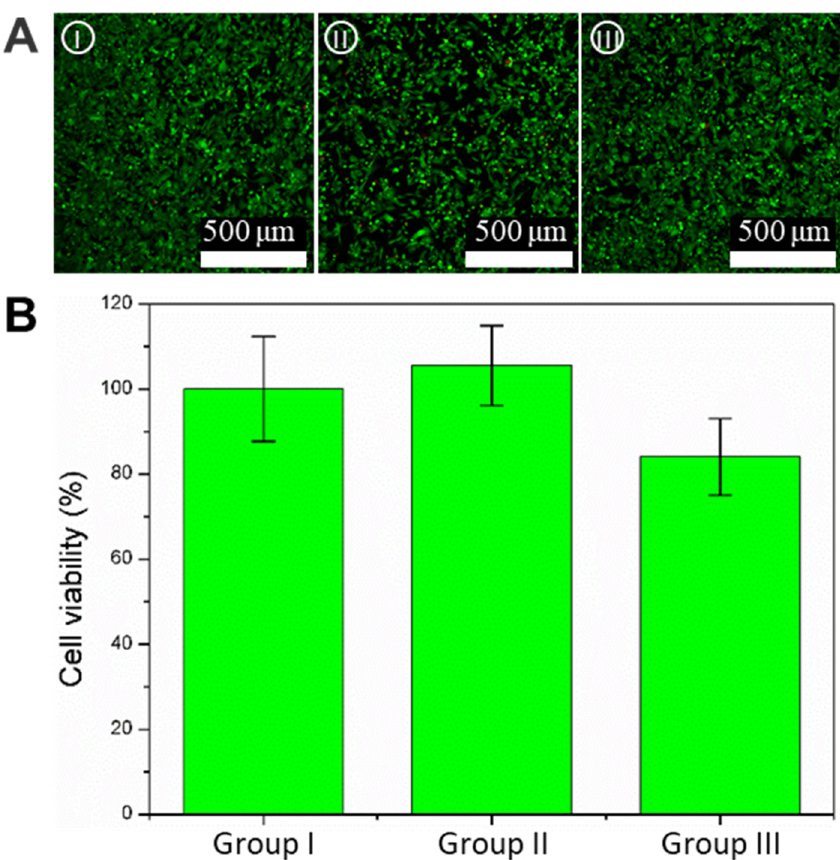
Figure 4. Biocompatibility test of the hydrogel crescent microswimmers. ( A ) Representative image of live/dead cell staining. Live cells (green) were stained with Calcein-AM, and dead cells (red) were stained with Calcein-PI. Groups I–III are the control group, the pure hydrogel group (microswimmers without magnetic nanoparticles), and the magnetic hydrogel microswimmers (microswimmers with 5 mg/mL magnetic nanoparticles), respectively. The scale bar is 200 µ m. ( B ) Cell viability after 24 h incubation for groups I–III. The sample size was